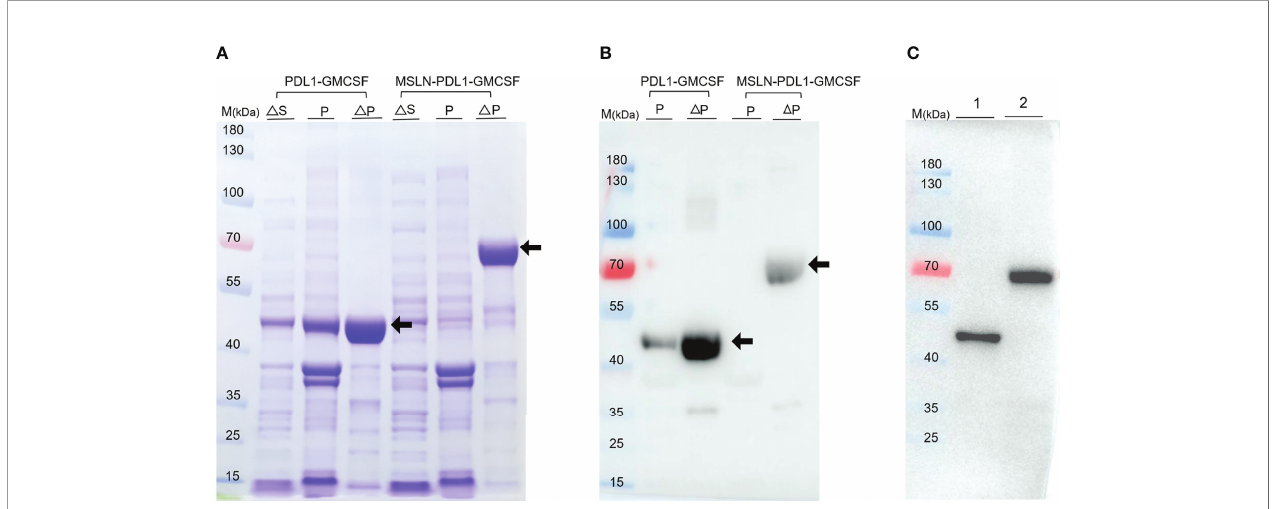
FIGURE 1 | Expression and puri fi cation of the recombinant protein PDL1-GMCSF and MSLN-PDL1-GMCSF. (A) The fusion protein consisting of human MSLN, PD- L1, Th epitope sequence and GM-CSF was designed. The recombinant protein PDL1-GMCSF and MSLN-PDL1-GMCSF in pellet and supernatant were inducted upon IPTG (0.1 mM) or IPTG-free at the expected size using SDS-PAGE analysis. (B) Western blot analysis of the puri fi ed protein PDL1-GMCSF and MSLN-PDL1- GMCSF using His-tagged antibody was shown. (C) Western blot analysis of the dialyzed proteins PDL1-GMCSF (lane 1) and MSLN-PDL1-GMCSF (lane 2) was performed with His-tagged antibody. M, Marker; S, Supernatant; P, Pellet; Δ , Induction by